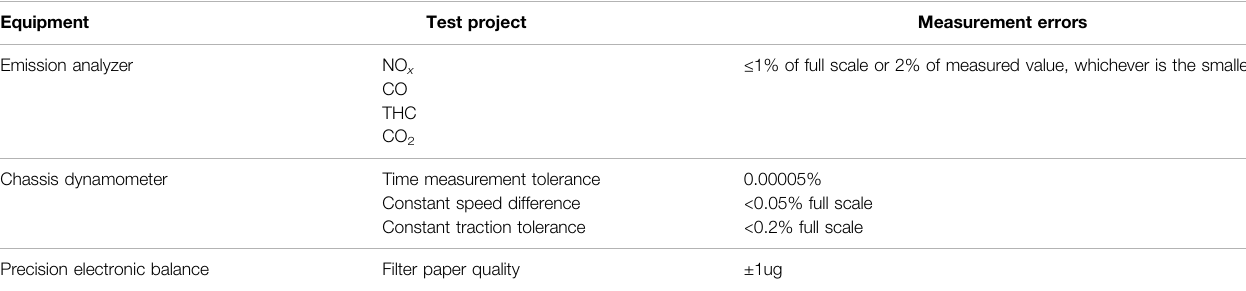
TABLE 3 | Measurement errors of the instruments (Liu, et al., 2019). Equipment